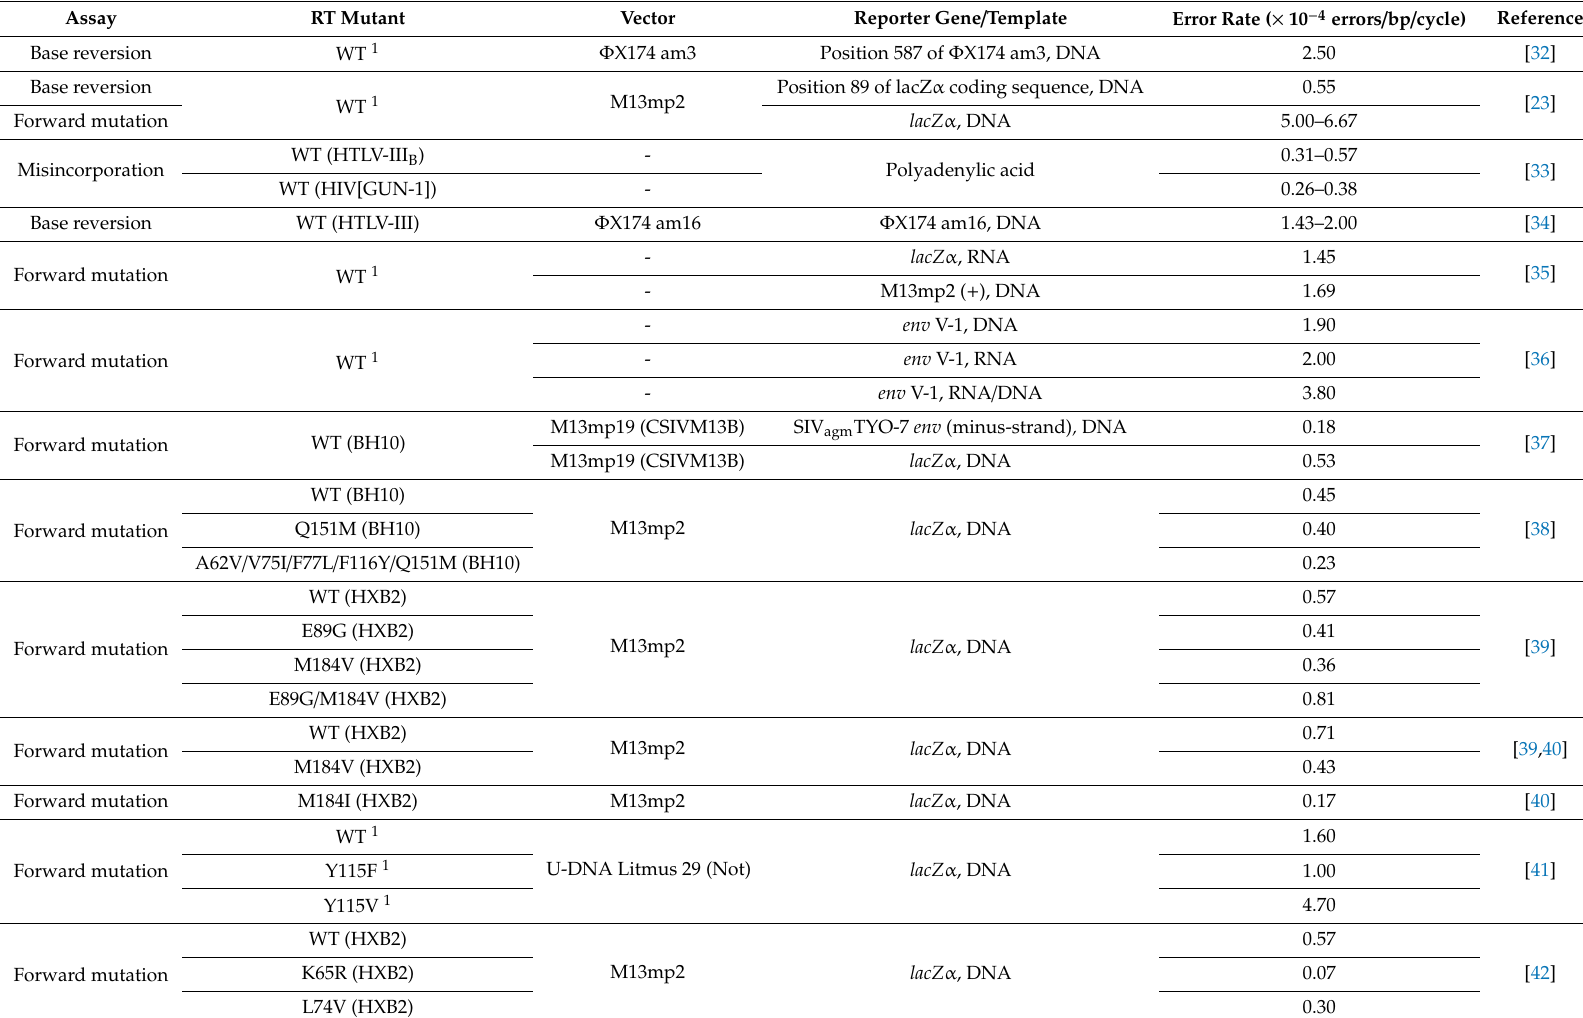
Table 1. Error rates of HIV-1 reverse transcriptase (RT) measured in cell-free fidelity